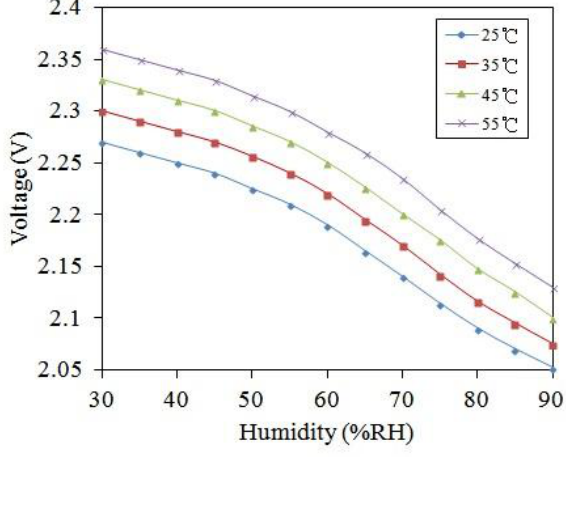
Figure 12. Measured results of the humidity sensor at different